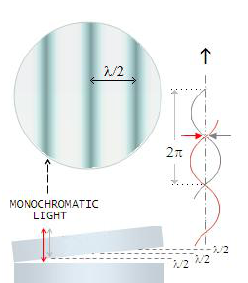
Figure 4: Interference pattern formation for straight surfaces (image source: http://www.telescope- optics.net/testing_optical_quality.htm#prevent)